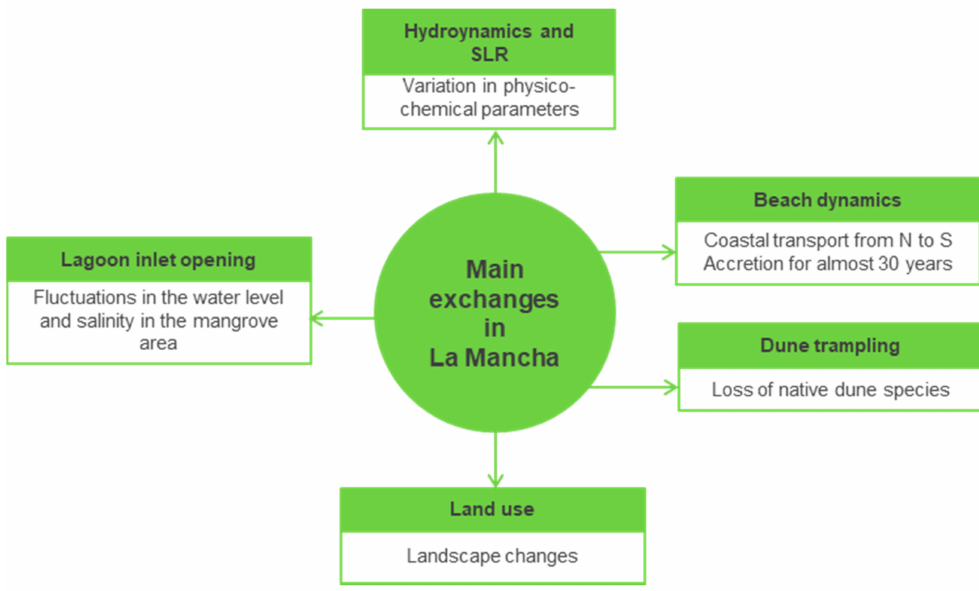
Figure 8. Main physical exchanges in La